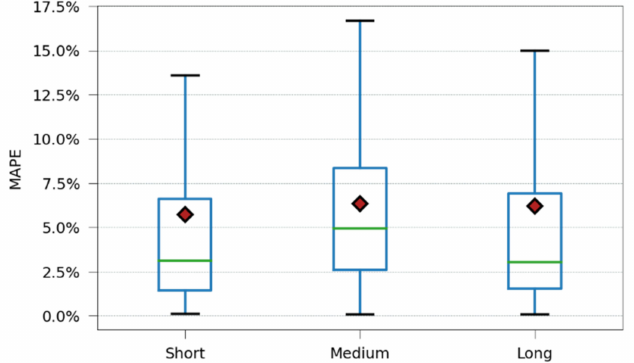
Figure A2. Boxplot of MAPE values by different temporal horizons. The same mode of display as in Figure 10. This shows that the length of the temporal horizon does not seem to necessarily have an impact on accuracy measured by